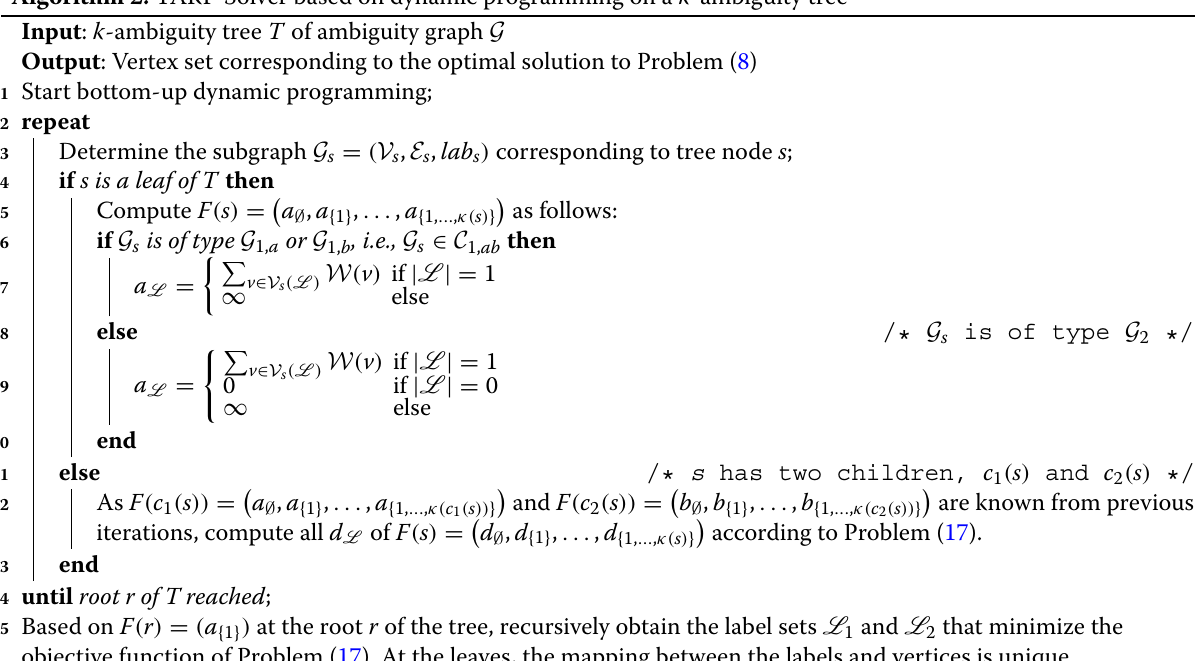
Algorithm 2: TARP-Solver based on dynamic programming on a k -ambiguity tree Input : k -ambiguity tree T of ambiguity graph